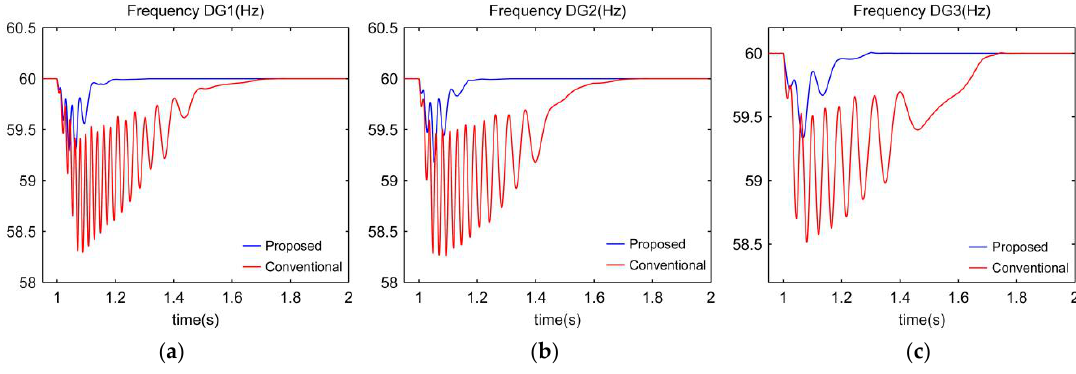
Figure 13. Frequency response of DG’s during islanding using proposed supplementary control